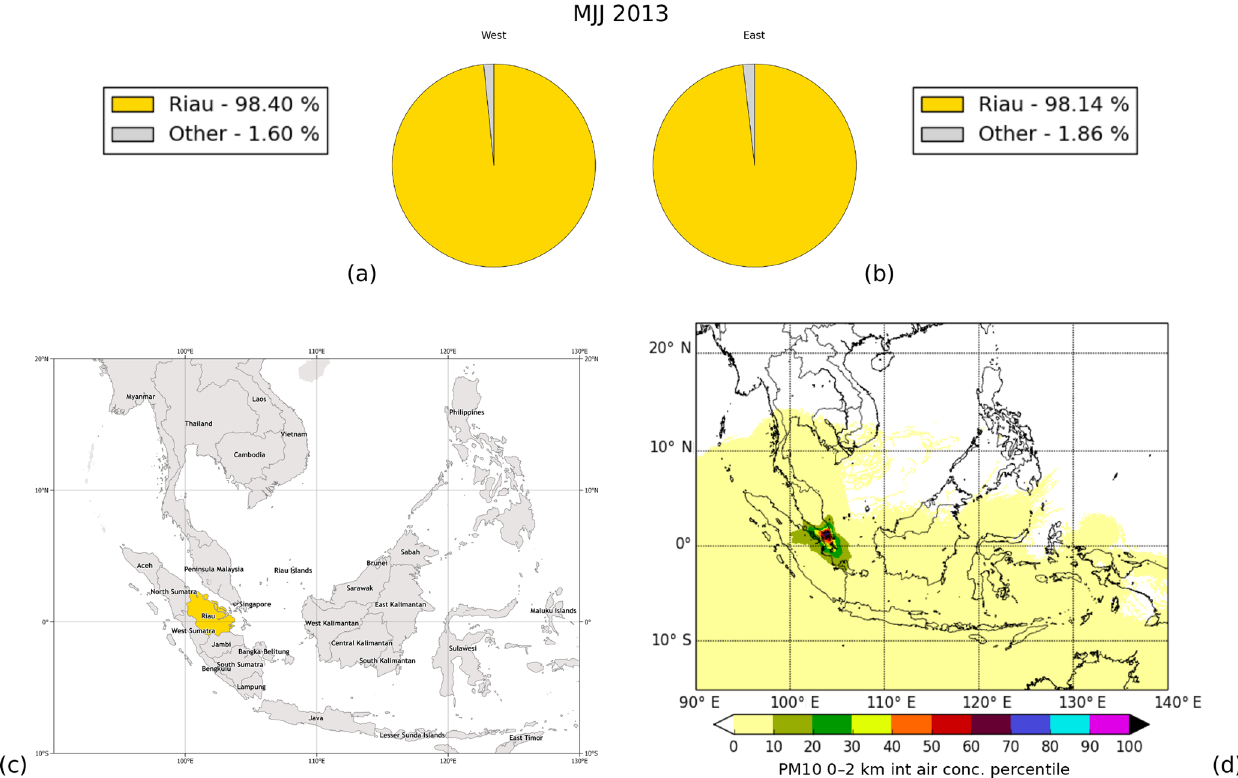
Figure 5. This figure shows results for PM 10 for MJJ 2013: pie charts for the western (NTU) (a) and eastern (TP) (b) monitoring stations showing major contributing source regions, (c) the regional map highlighting only the major contributing source region, and (d) the air history map showing where the air arriving in Singapore originated from in MJJ 2013. The “Other” category in the pie charts is from sources which individually contribute less than